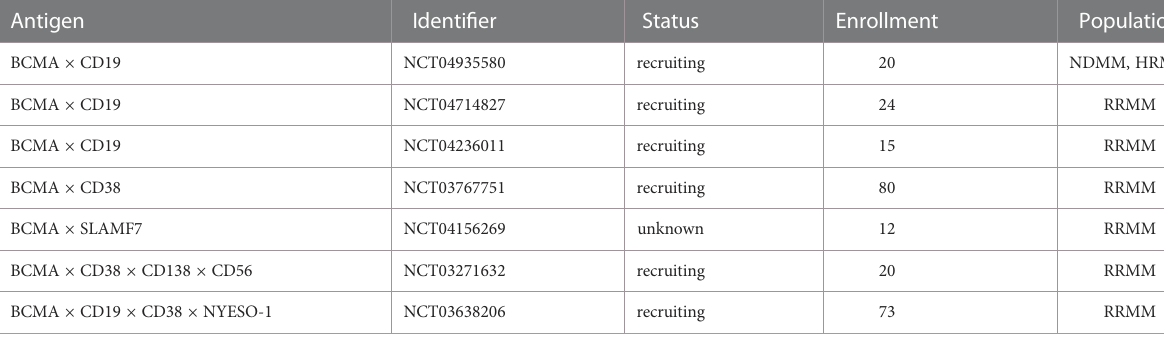
TABLE 4 Dual-target or multi-target strategy tested in early clinical trials.